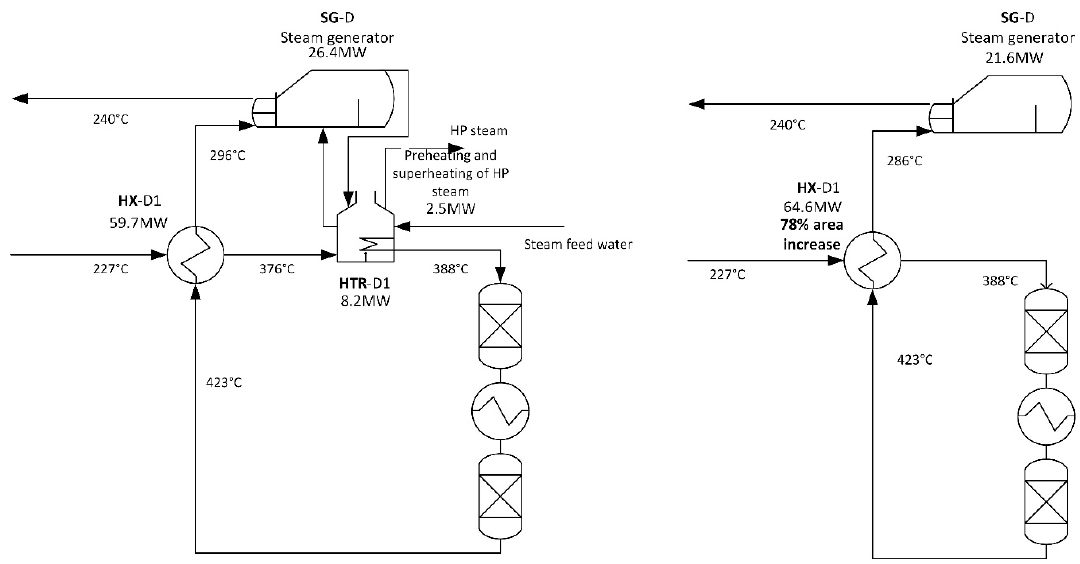
Figure A10. The process current configuration is shown to the left in the figure and retrofit proposal 5 is shown to the right.